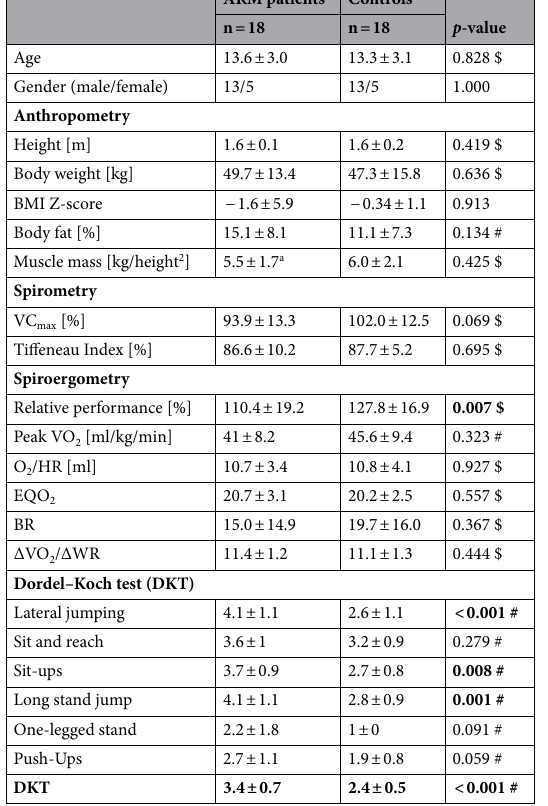
Table 2. Anthropometric data, results of spirometry and spiroergometry and Dordel-Koch-Test (DKT) of ARM patients and controls (n = 18 each). Bold values indicate statistically significant differences. All data are displayed as mean ± standard deviation and statistical comparison was performed using either unpaired t-tests ($) or Mann–Whitney-U tests (#) depending on normal distribution and homogeneity of variances. a Measurement of muscle mass was technically not possible in one control